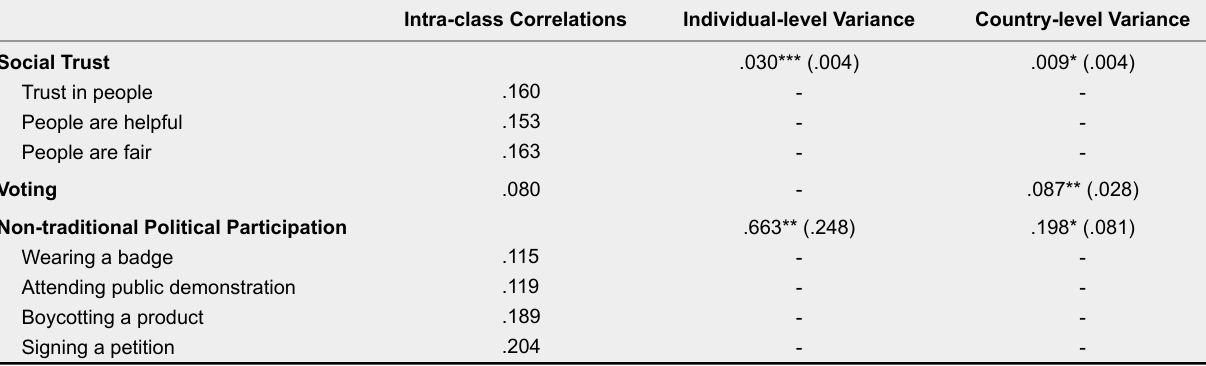
Factor Loadings for the Full Model Social